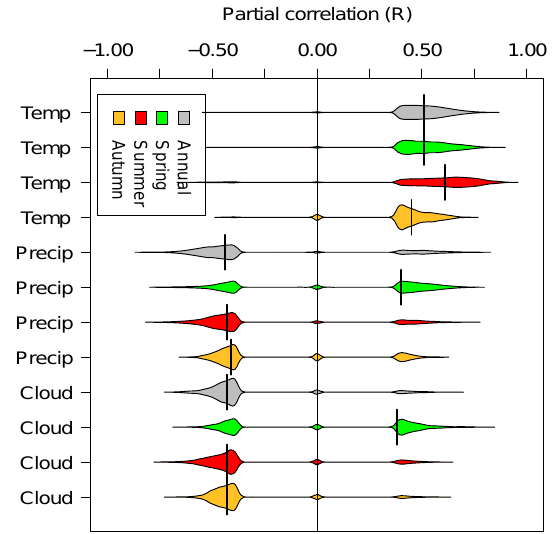
Figure 7. Bean plots of the multi-modal distribution for significant (95% significance) partial correlation between annual de-trended GPP (GPPsat) and the values of each de-trended environmental variable after eliminating the influence of the other variables. A bean plot is an alternative to the box plot and is fundamentally a one-dimensional scatter plot. Here it is preferred over a box plot as it helps to show a multi-modal distribution. The thickness of a “bean” is a function of the frequency of the specific value – that is, the thicker a “bean” is for a value, the relatively higher the number of grid points having that value. The values shown are the Pearson’s correlation coefficients which are based on the linear least-squares trend fit. Correlation values range from − 1 to + 1. Values closer to − 1 or + 1 indicate strong correlation, while those closer to 0 indi- cate weak correlation. The colour of the box indicates the season of the environmental variable being investigated (annual: grey; spring: green; summer: red; autumn: amber). The short horizontal black lines for each “bean” is the median of that distribution.